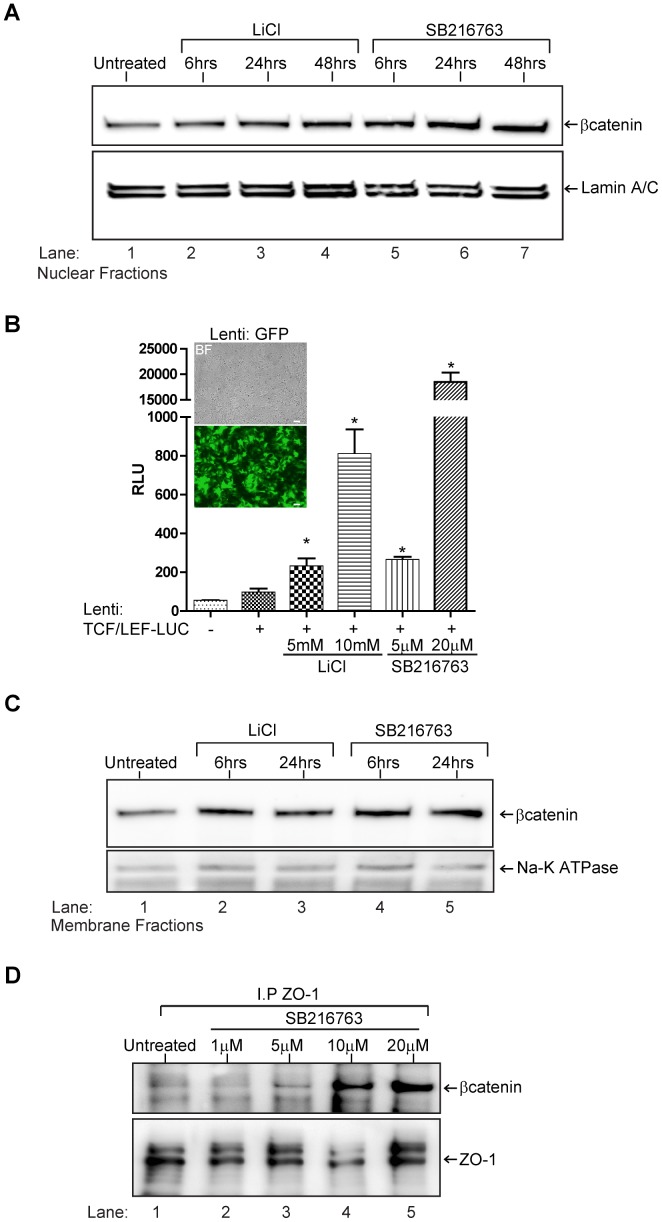
Effects of GSK3β inhibition on transcriptional and structural β-catenin in BMVEC.(A) Western blots of BMVEC nuclear fractions show a time-dependent increase in β-catenin accumulation in cells treated with LiCl (10 mM) or SB216763 (20 µM); lamin A/C denotes the loading control. (B) Results from luciferase assays of BMVEC transduced with lentiviruses containing the TCF/LEF sensitive luciferase reporter. A significant increase of the luciferase reporter is evident in BMVEC treated with the indicated GSK3β inhibitor (concentrations are the same as above) for 24 hr. Representative images showing lentiviral transduction efficiency (∼90%) in BMVEC using a lentiviral construct expressing a GFP reporter (insert, 5X objective magnification, scale bars: 100 microns). The luciferase results are expressed in relative light units (RLUs) after normalization with measurements provided by a co-infected (lentivirus) renilla luciferase internal control. The values are shown as the mean ± SEM (n = 3), * denotes a difference of P<0.05 when compared to the transduced but untreated condition. (C) Western blots from BMVEC membrane preparations showing membrane bound β-catenin after cells were exposed to LiCl or SB216763 (concentrations as above) for 6 and 24 hr (Na/K ATPase serves as the loading control). (D) Enhanced β-catenin association with ZO-1 observed by co-immunoprecipitation analysis. BMVEC monolayers were incubated without or with escalating doses (1–10 µM) of SB216763. Proteins were extracted under native conditions, immunoprecipitated (I.P.) for ZO-1 and immunoblotted (I.B.) for β-catenin.